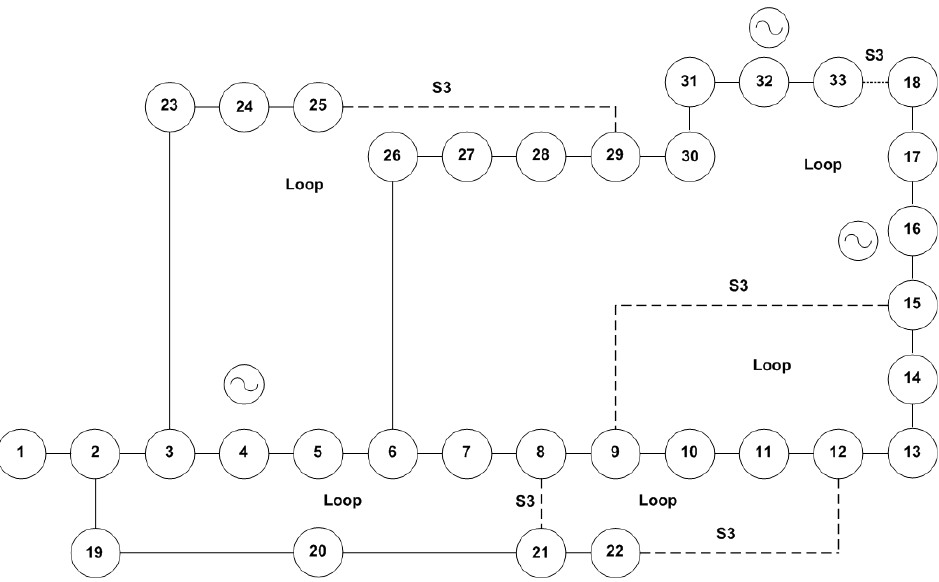
Figure 5. The distribution network (DN) reconfiguration.